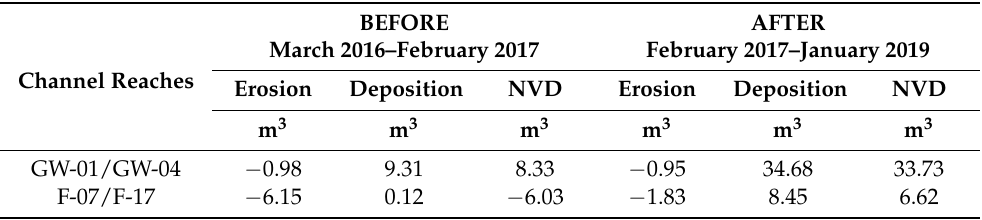
Table 5. Total volume of erosion and deposition registered before and after check dam construction Figure 8. Resulting digital elevation models of differences (DoD) for two reaches at the upper reach for the reaches presented in Figure 8. BEFORE = before check dam construction. AFTER = after check ( a , b ) before check dam construction (DoD 2016–2017) and ( c , d ) after check dam construction (DoD dam construction. NVD = net volume difference. 2017–2019). Note that ( c ) shows four gabion weirs (GWs) while ( d ) presents one GW and 11 fas- cines (Fs).